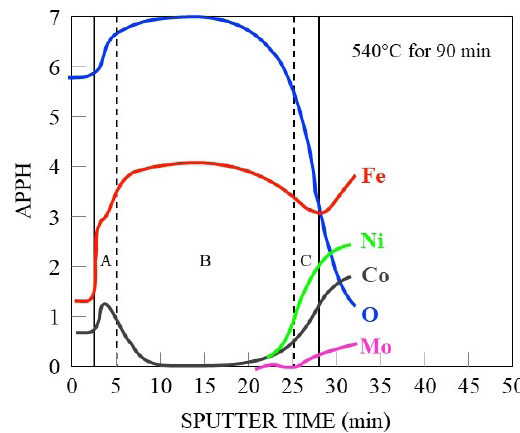
Figure 11 . Concentration profile of several elements (O, Fe, Ni, Co, Mo) obtained by AES-AIS in the maraging 300 steel after exposure at 540 °C for 90 minutes. The sputtering rate used was 19 nm/min 49